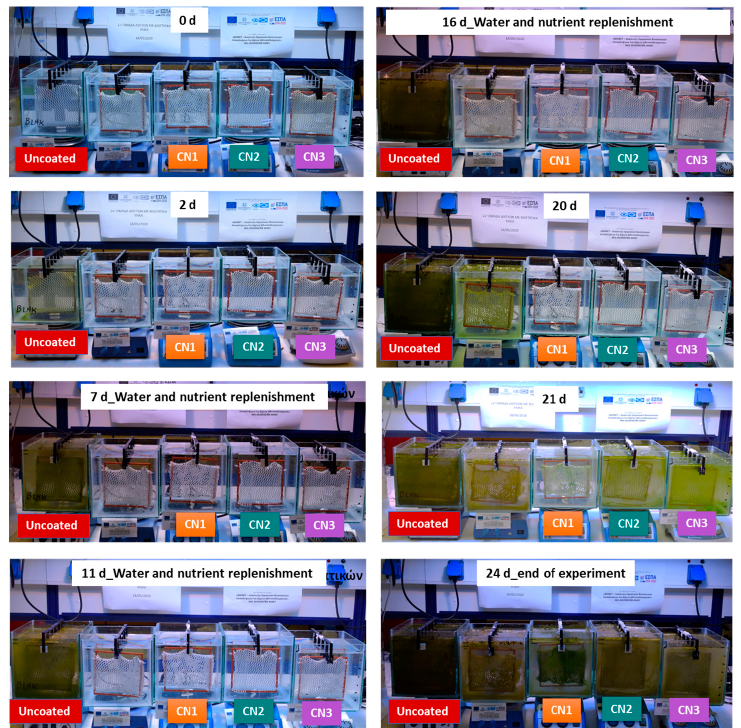
Figure 7. Study of the polymeric coatings against biofouling after immersion in seawater for 24 days under accelerated conditions. Water and nutrient replenishment were carried out at intermediate time intervals.